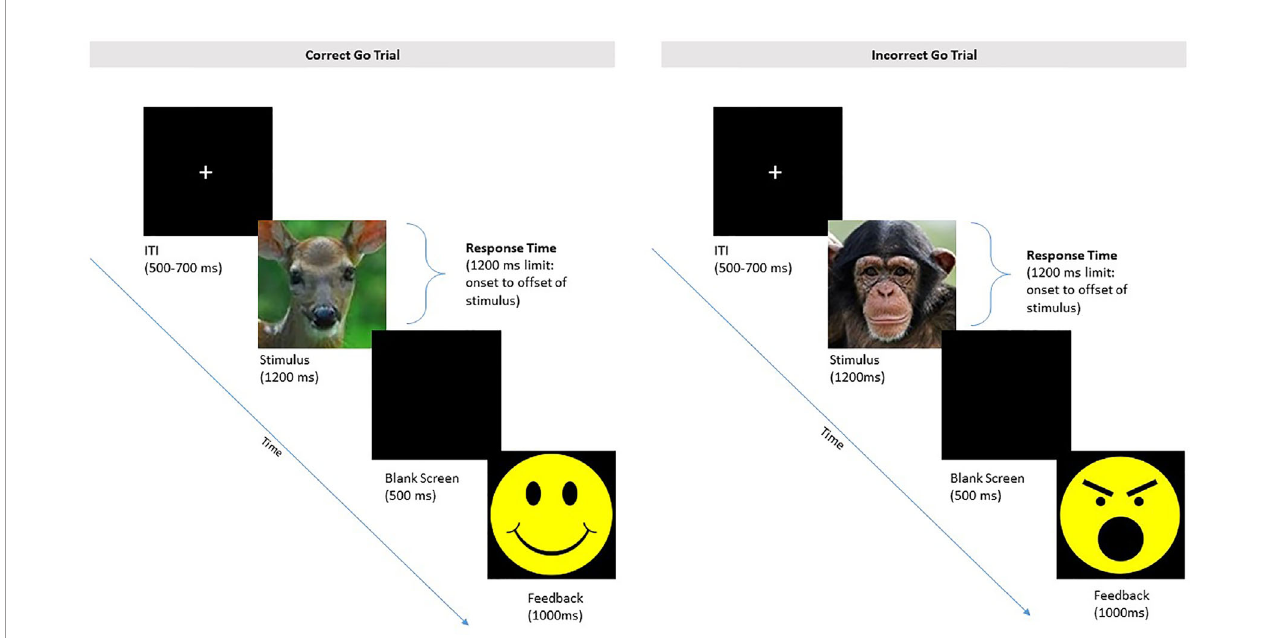
FIGURE 6 | Depiction of the Zoo Go No-Go Task for children. Participants respond with a button-press when an animal (e.g., deer) appears in the go task. Children are instructed to withhold a response when the monkey appears. Children are presented with smiley-face feedback for correctly withholding a response, and angry- face feedback for incorrectly responding to a